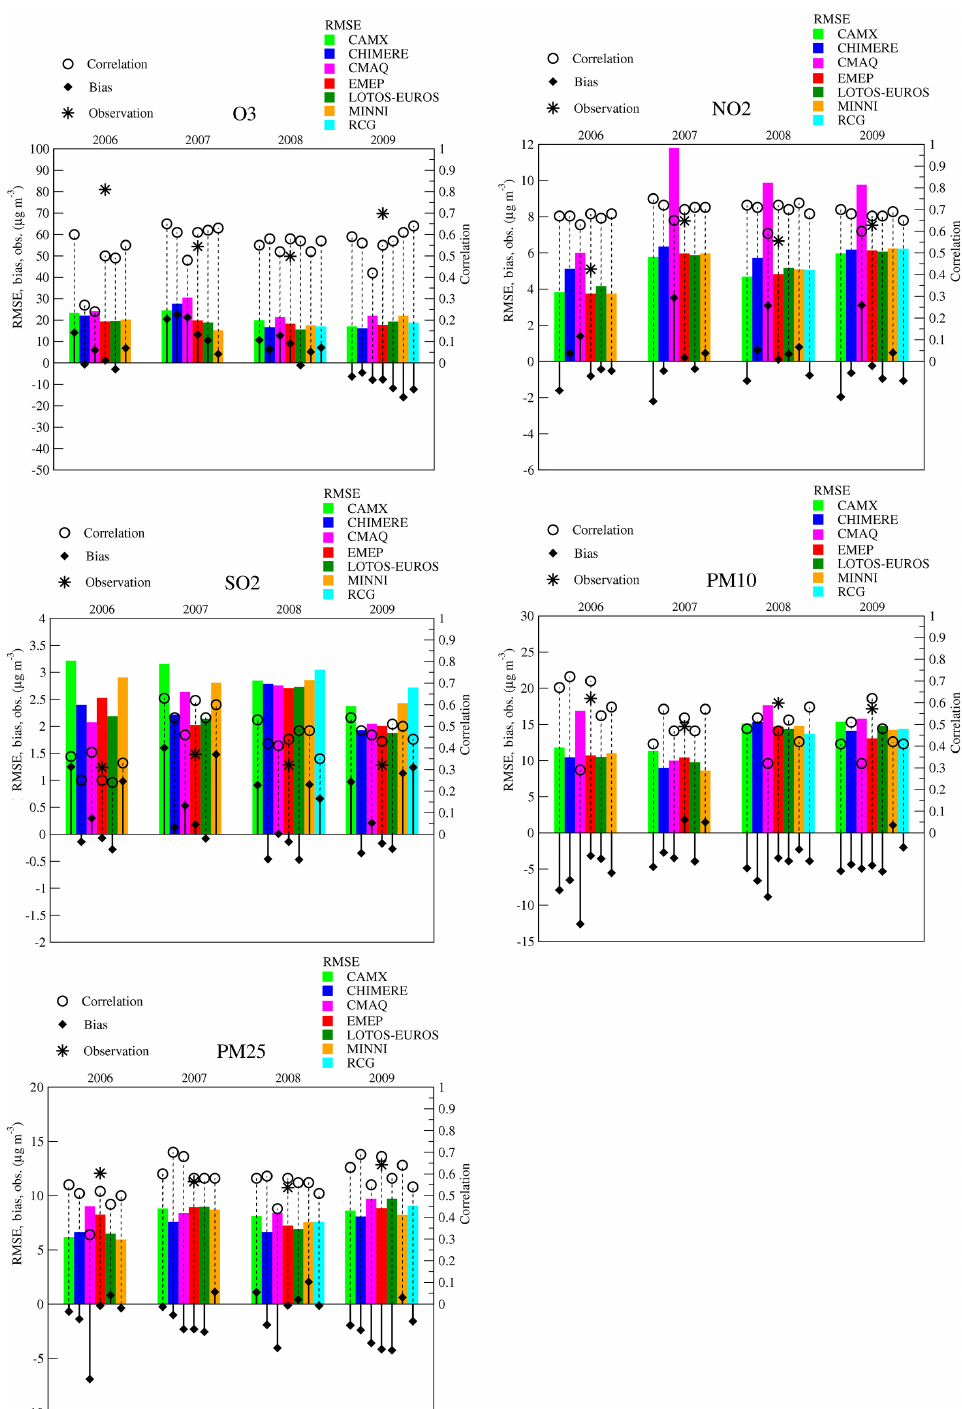
Figure 4. Overall performance of models for ozone, nitrogen dioxide, sulfur dioxide, PM 10 and PM 2 . 5 daily mean concentrations for all